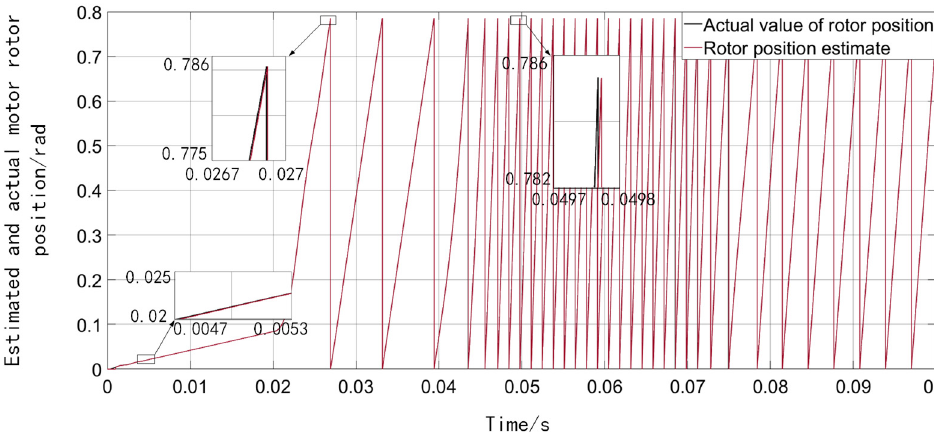
Figure 20. Comparison of the rotor position of the new improved SMO at full speed.